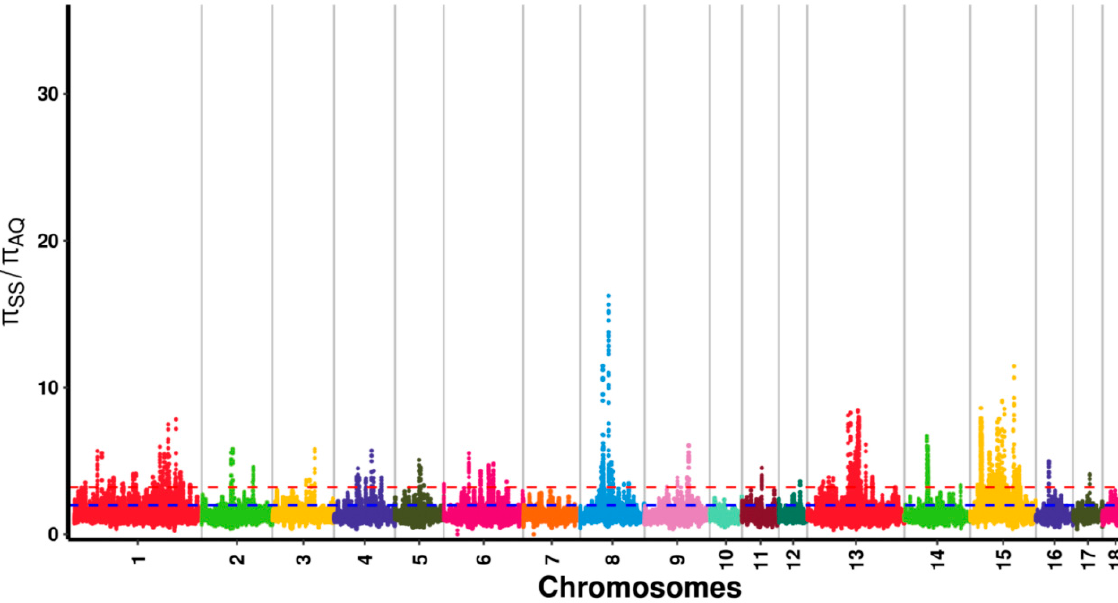
Figure 4. Distribution of π ratio among Anqing six-end-white pig autosomal chromosomes. Note: The red line represents the 0.01 level., and the blue line represents the 0.05 level. The different colors indicate that the SNPs are located on different chromosomes.